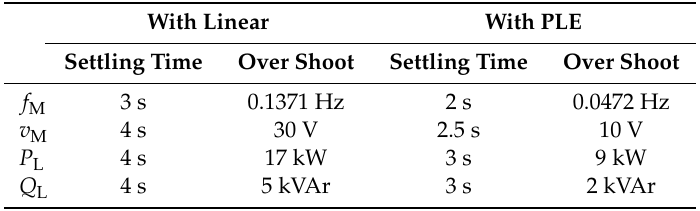
Table 2. Dynamic performance comparison of linear and PLE droops for a step change in load demand. With Linear With PLE Settling Time Over Shoot Settling Time Over Shoot f M 3 s 0.1371